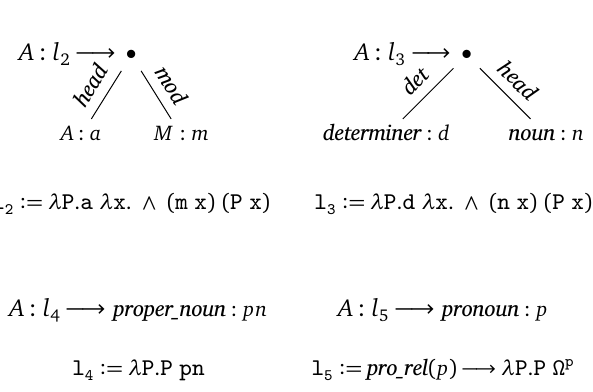
Figure 12: Semantic linearization rules for productions p